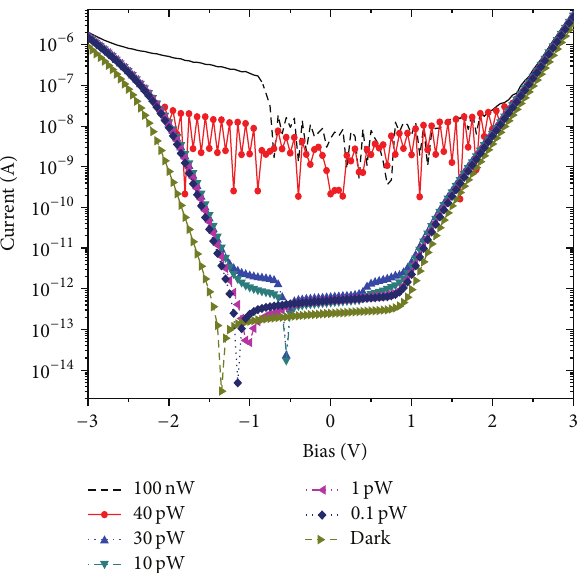
Figure 2: The I - V curves at different illumination